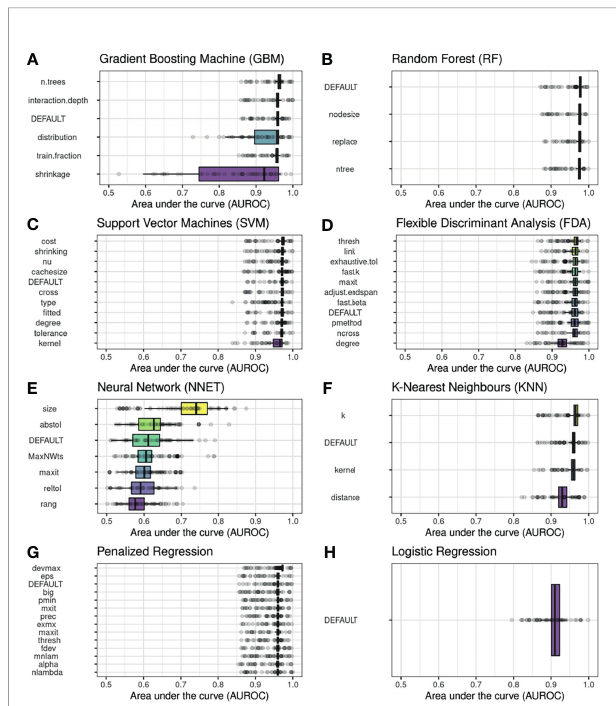
FIGURE 1 | Hyperparameter tuning in our set of machine learning classi fi ers. The impact of varying the default values of a single hyperparameter on the area under the curve (AUROC) is illustrated for a selection of hyperparameters in each algorithm (shown on the ordinate). Each hyperparameter is sampled 50 times and its performance is assessed within a repeated cross-validation sampling (three-fold, 4-repeats), resulting in an AUROC distribution, which is illustrated with a box and whiskers plot. The outcome was dependence on dopamine agonists at long-term follow-up. For comparison, the range of AUROC values derived using the default hyperparameter settings are shown as DEFAULT in each panel. Due to the repeated cross-validation sampling, the default hyperparameter settings also feature AUROC distributions, despite using only a fi xed set of